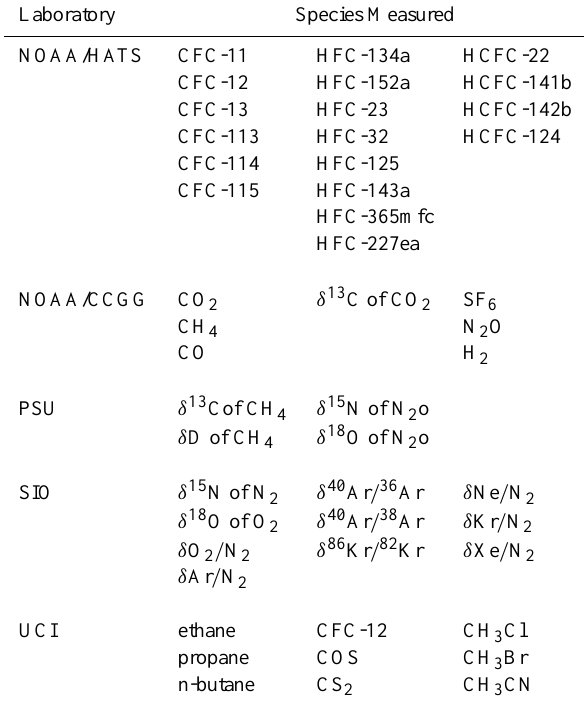
Table 1. Laboratories involved in analyses of the WAIS-D firn air samples, and the species they measured. In addition to the species listed, the NOAA/HATS laboratory also measured se- lected hydrocarbons, halogenated hydrocarbons and carbonyl sul- fide. Responsible parties for each laboratory are Stephen Montzka (NOAA/HATS), Pieter Tans (NOAA/CCGG) Todd Sowers (PSU), Jeff Severinghaus (SIO) and Murat Aydin (UCI). Contact informa- tion is given below the author